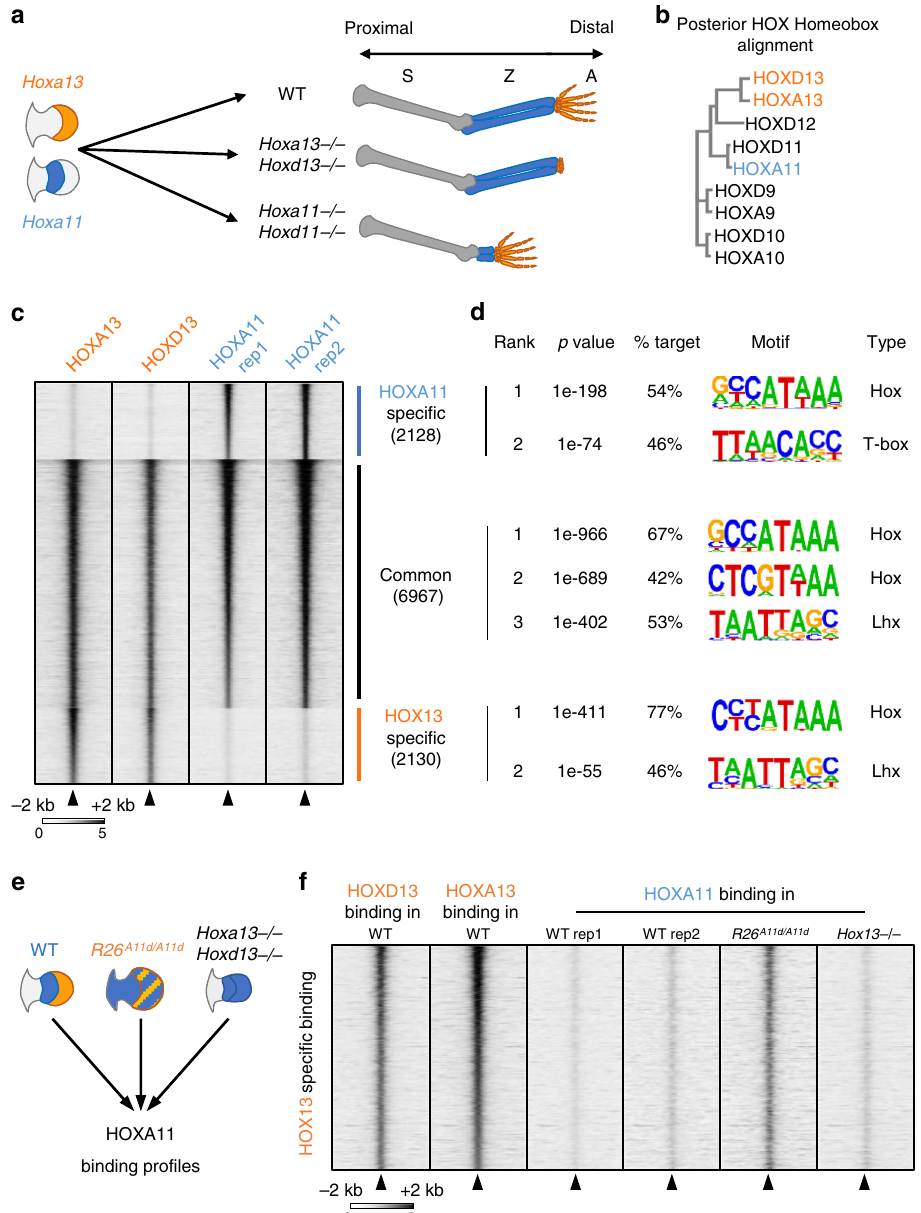
Fig. 1 Loss of HOX13 speci fi city upon Hoxa11 expression in distal limb buds. a Schematics illustrating the mutually exclusive expression pattern of Hoxa11 and Hoxa13 in mouse limb buds (left) as well as the forelimb phenotype associated with the inactivation of Hoxa/d11 and Hoxa/d13 (right). b Alignment of 5 ′ Hoxa and Hoxd homeobox sequences revealing the close relationship between HOXA/D11 and HOXA/D13. c Heatmap showing ChIP-seq read density of HOXA11 (blue) and HOXA/D13 (orange) at all peaks for HOXA11 and HOXA13 with a p value < 10 − 20 , in a 4 kb window. Peaks are ranked based on p value (Poisson distribution p value based on lambda and corrected for multiple comparison using the Benjamini – Hochberg correction computed by MACS2) and according to the binding speci fi city. Color scale indicates reads per million reads (RPM). d Top scoring motif uncovered using HOMER de novo motif analysis in a 200 bp window around the peaks center, for the three categories depicted in panel ( c ). e Schematics showing the expression pattern of Hoxa11 (blue) and Hoxa13 (orange) in wild type, Prrx1Cre;Rosa Hoxa11/Hoxa11 mouse ( R26 A11d/A11d ) and Hoxa13 − / − ;Hoxd13 − / − ( Hox13 − / − ) mouse limb buds. These were used to assess binding of HOXA11. f Heatmaps showing a 4 kb window of ChIP-seq read density for HOXA13 and HOXD13 in wild type (left), HOXA11 in wild type (middle), R26 A11d/A11d and Hox13 − / − (right) E11.5 forelimb buds at HOXA13-speci fi c peaks with a p value < 10 − 20 . Peaks are ranked based on p value of HOXA13 binding (Poisson distribution p value based on lambda and corrected for multiple comparison using the Benjamini – Hochberg correction computed by MACS2). Color scale indicates reads per million reads (RPM). Source data are provided as a Source Data fi